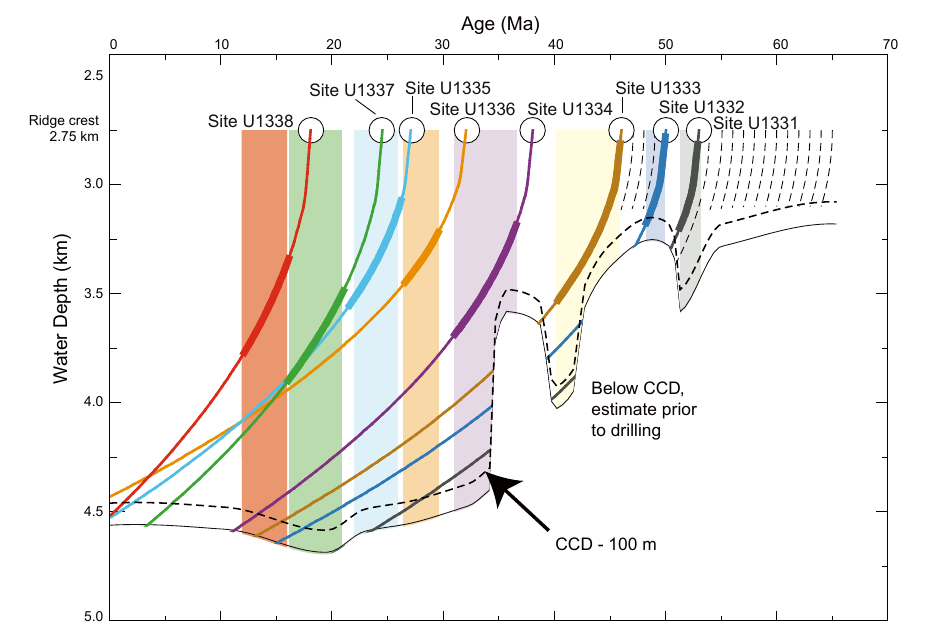
Figure 2. Targeting drill sites prior to coring based on calcium carbonate compensation depth (CCD) history (van Andel, 1975), with additional data from Leg 199. Colored boxes = critical time interval targeted for each site. Colored subsidence lines are critical time intervals where we also expected carbonate to be deposited (i.e., when site is above CCD). Subsidence curves use a subsidence parameter calculated from estimated basement age of PEAT sites and their present-day depth (k = ~0.35). Additional subsidence due to sediment loading was not